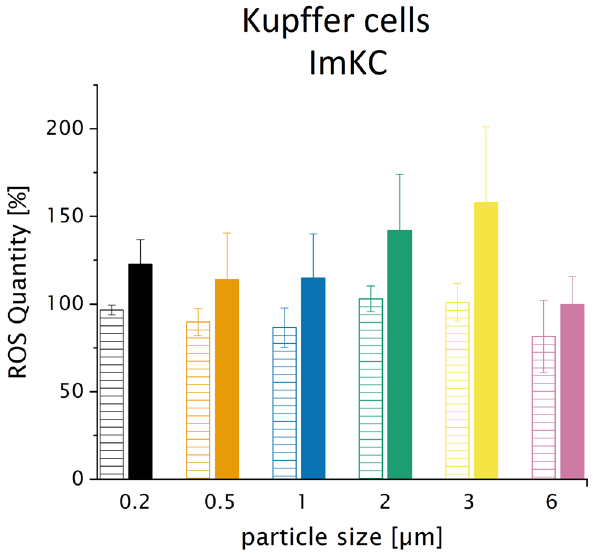
Figure 4. The appearance of reactive oxygen species upon increasing particle concentrations for ImKC macrophages. ROS of the whole cell population treated with an increasing particle concentration (striped bars = low concentration; full bars = high concentration). Quantity is represented in relation to a negative control without particles (100%). Data represent mean ± SD, n =